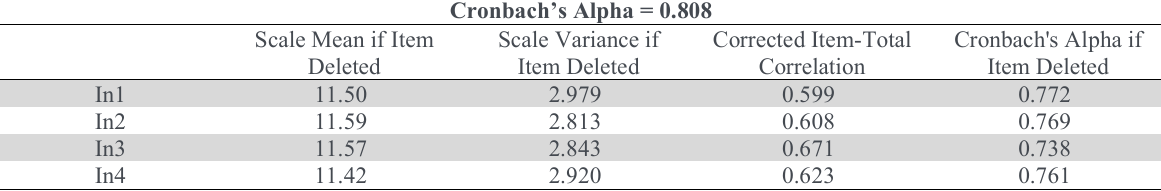
Cronbach’s Alpha test results of innovative work behavior